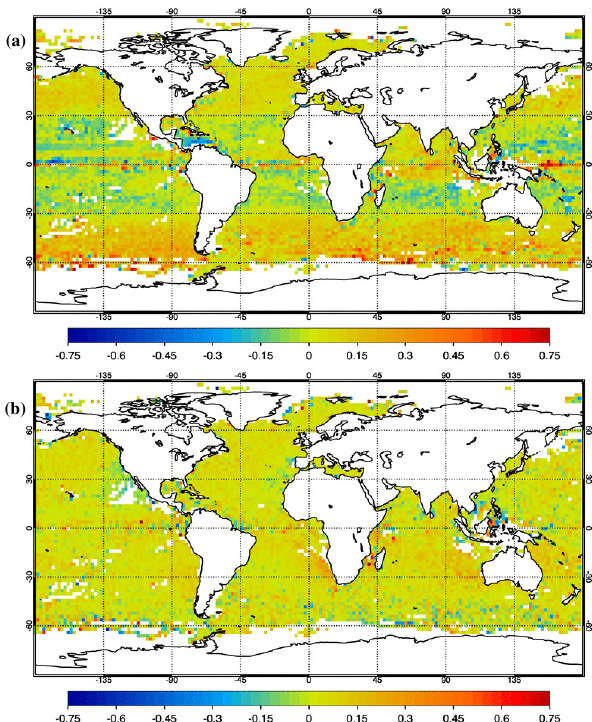
Figure 4: Mean error (observed-modelled) against drifters for (a) zonal velocity and (b) meridional velocity in 2º bins.